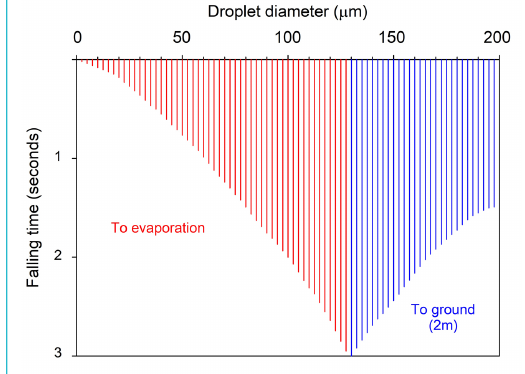
Figure 1: Falling and evaporation times of droplets of varying di- ameters. On the left side the red lines indicate that the time for a droplet (nucleus) to cease to exist as a result of evaporation is identical to the falling time. This time is shorter than the falling time to the ground without evaporation. On the right side the blue lines indicate that the falling time is shorter for a larger droplet (nucle- us), reaching the ground without evaporation and earlier than a smaller droplet (nucleus). 1 μm [micrometer] = 0.001 mm Adapted reproduction from Wells [6] with permission of the publisher (Ox- ford University Press on behalf of Johns Hopkins